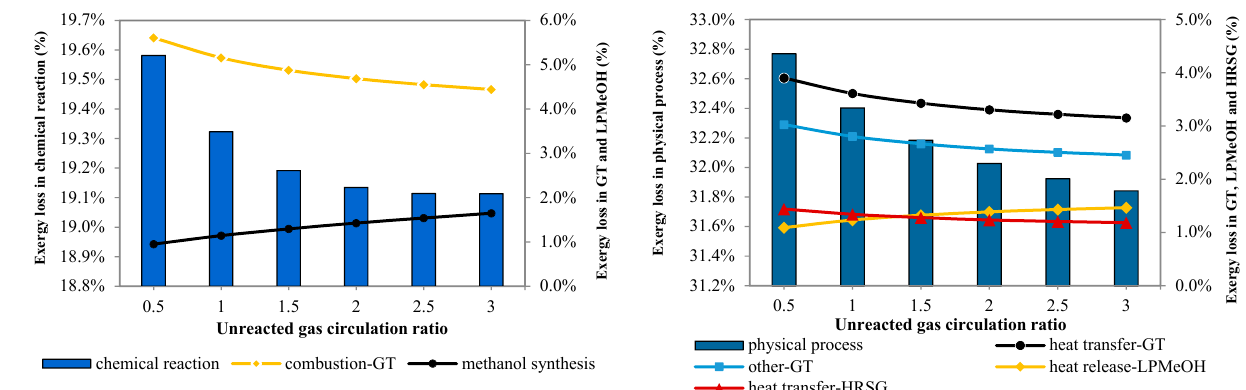
Figure 9. Exergy loss of chemical processes in the no-shift series polygeneration system. Figure 10 illustrates the effect of λ on the overall exergy efficiency and physical ex- ergy efficiency.